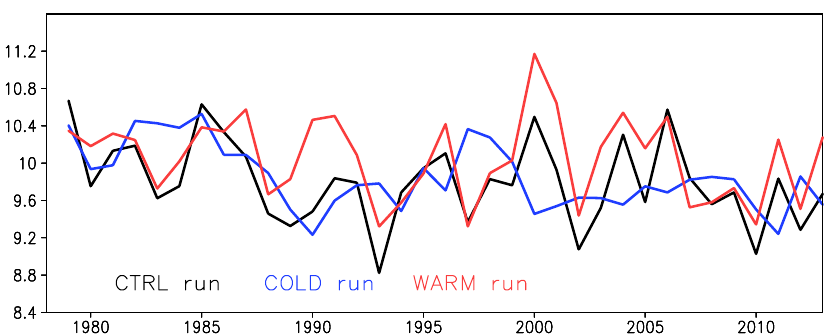
indicates that an entrainment process plays an important role in the ML temperature variation. The late-winter ML temperature is not correlated with the winter NHF ( r = 0.18, non-significant correlation), so the winter NHF variation cannot be the main cause of the ML temperature variation. However, the winter NHF indirectly affects the ML temperature through modulation of the ML depth. Similar to the CTRL run result, the ML tempera- ture in the COLD run shows decadal variation and a warming trend (0.028 °C year –1 ) (Fig. 7c). The detrended ML temperatures in the CTRL and COLD runs are correlated ( r = 0.84, exceeding the significance level of 0.1). However, the temporal features of the ML temperature in the CTRL run are not fully reproduced in the WARM run; the positive trend is reproduced (0.030 °C year –1 ), but not the decadal variation (Fig. 7c). These results indicate that the late-winter ML temperature variation in the STMW formation region is attributable to cold-